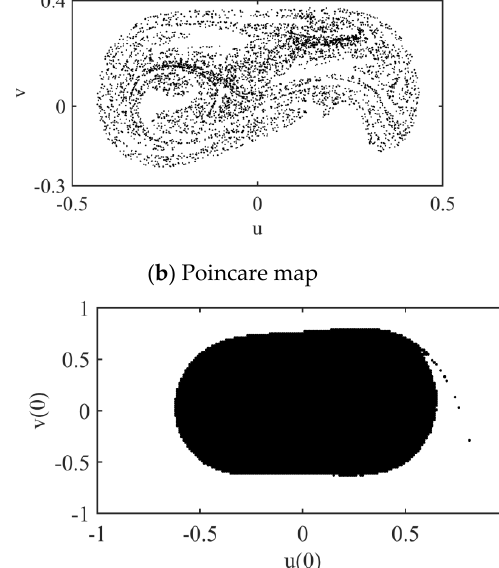
Figure 7. Evolution of multiple attractors and their basins of attraction under different values of V AC .